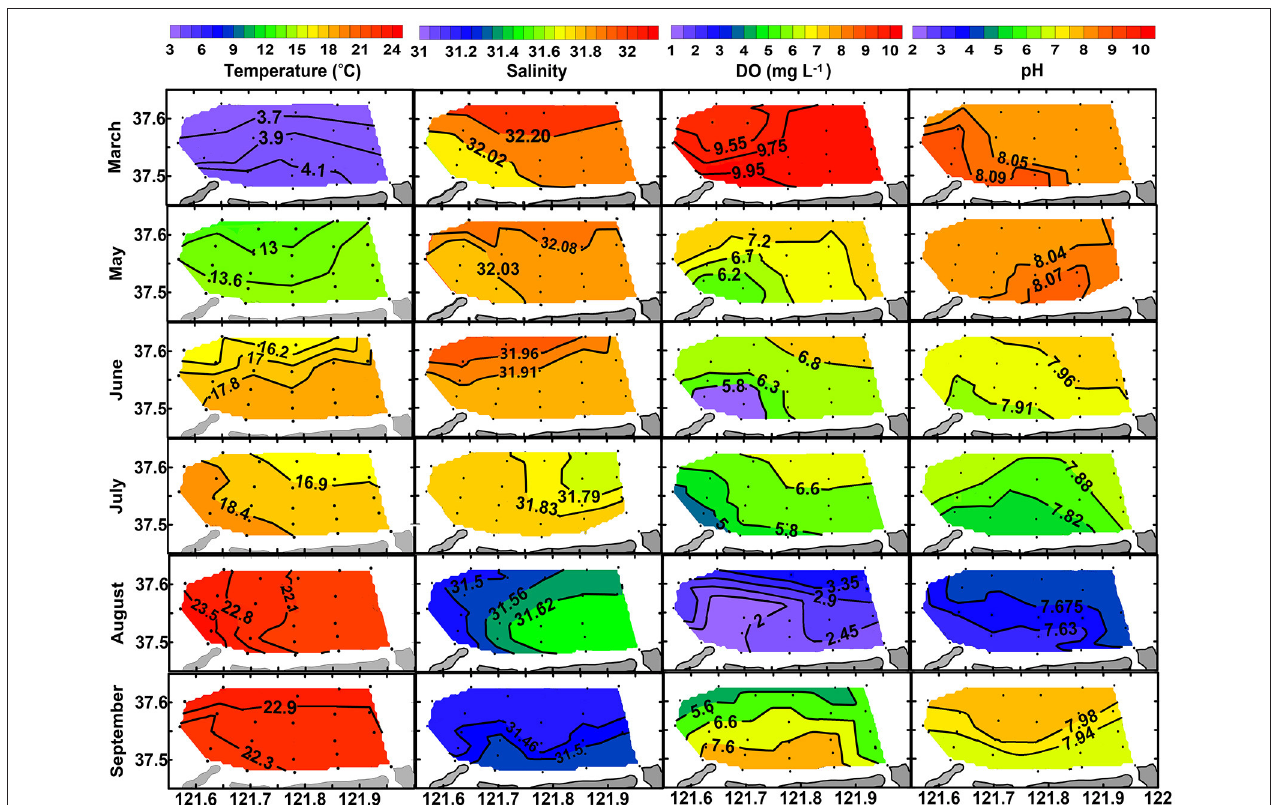
FIGURE 4 | Bottom distribution of temperature ( ◦ C), salinity, DO (mg L − 1 ), and pH from March to September of